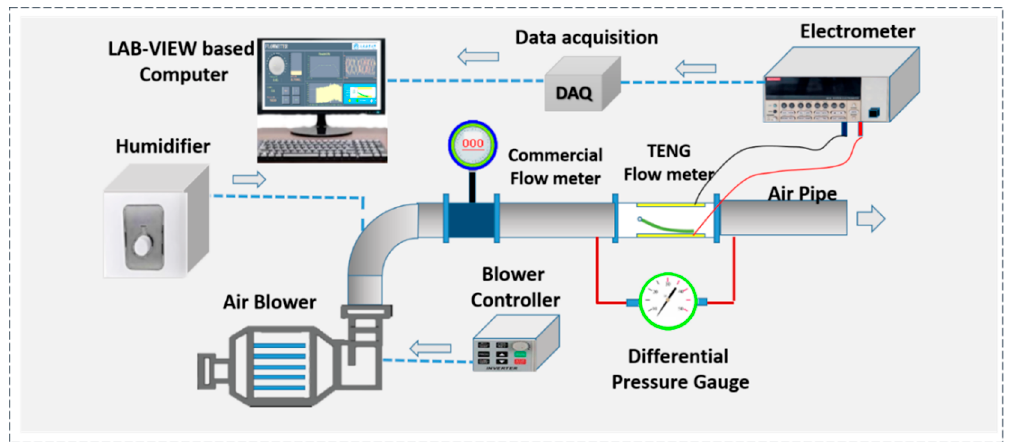
Figure 2. TENG flowmeter experimental apparatus.